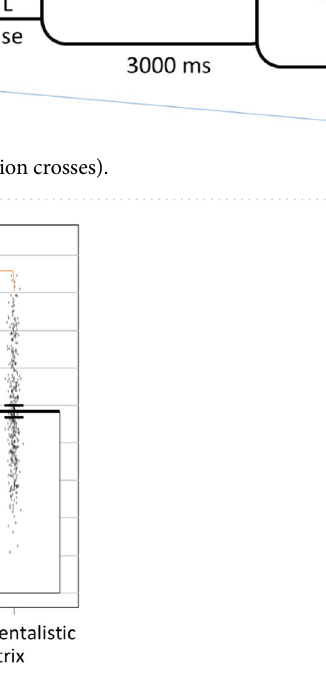
Figure 9. Time to select mechanistic or mentalistic descriptions as a function of the cognitive load induced by the complex vs simple matrices. The RTs correspond to the time of response after the activation of the responses keys (or 3000 ms after the display of the